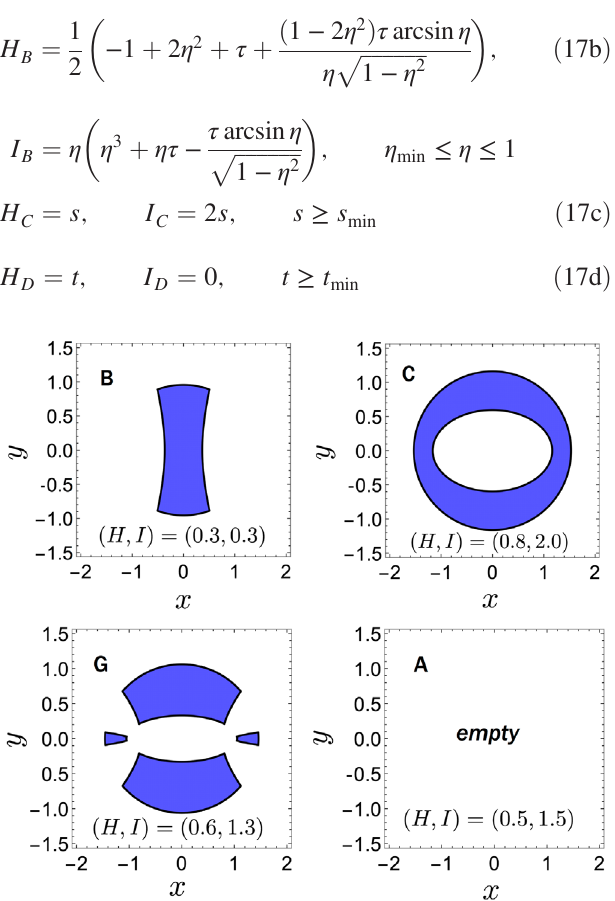
FIG. 4. Projections of level sets from each of the four regions shown in Fig. 3 ( τ ¼ − 0 . 4 ). A non-resonant orbit on such a level set densely fills one of its connected components. (B) One connected component, not intersecting the branch cuts. (C) One connected component, intersecting the branch cuts (hole visible). (G) Four connected components. (A)